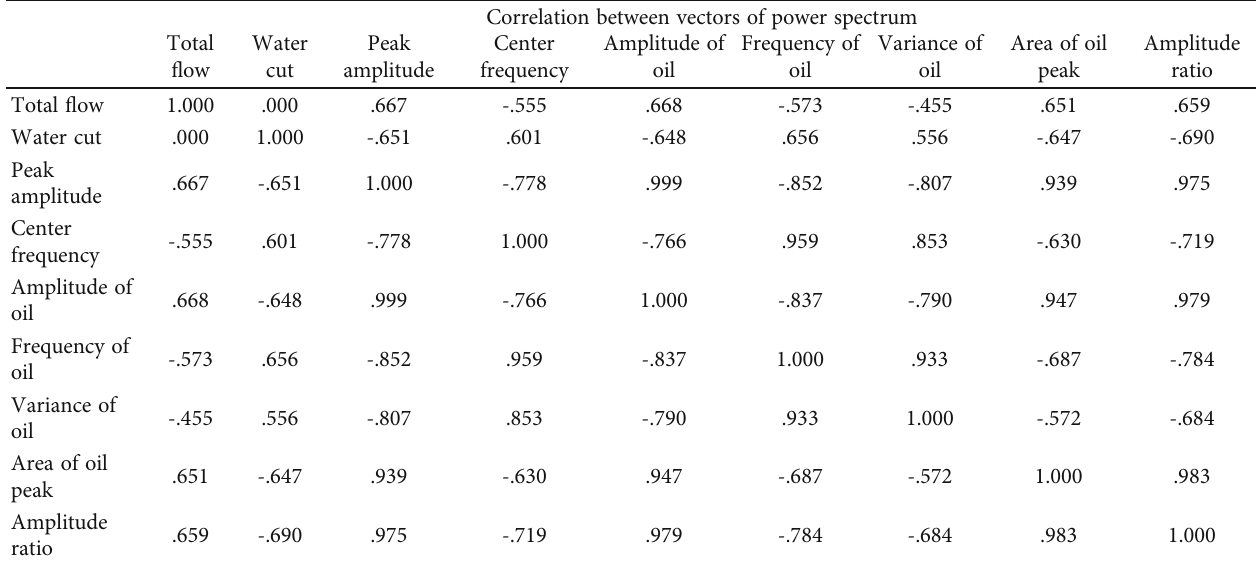
Table 3: Approximate value matrix table of related variables for oil-water two-phase fl ow.